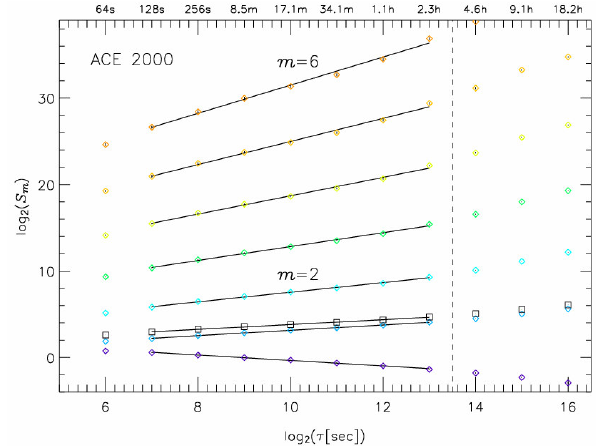
Fig. 9. The gradients of the weighted least squares curves ζ ( m) es- timated from Fig. 8, versus order m over the range m =− 1 to 7. The error bars are drawn at the 3 σ level. The gradient of the weighted least squares curve to the ζ ( m) points gives α GSF =0.287 ± 0.006 (1 σ error).